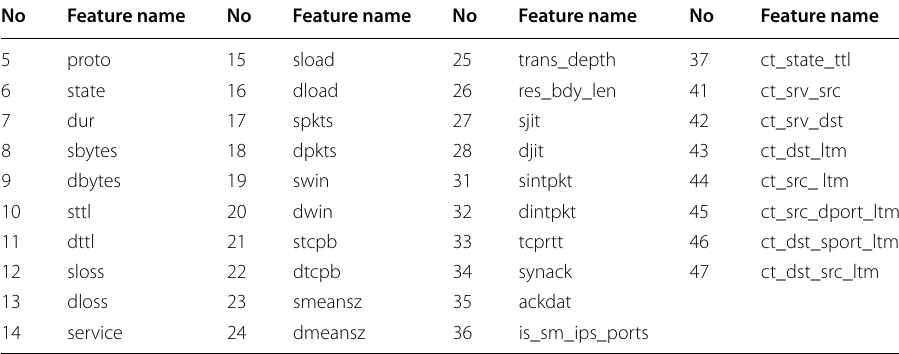
Table 7 Features of UNSW-NB15 data set after data filtration